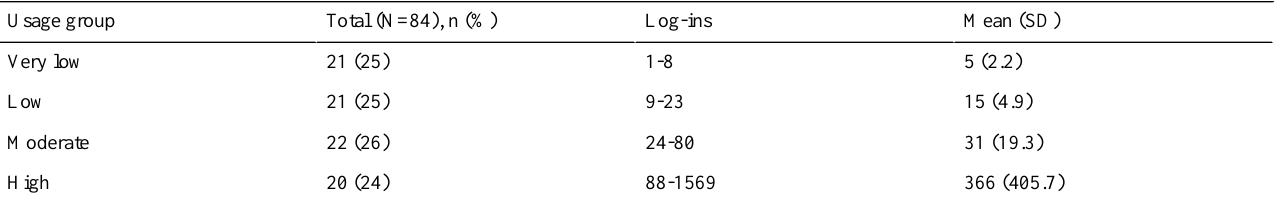
Table 1. Log-ins, mean, and standard deviation associated with each usage